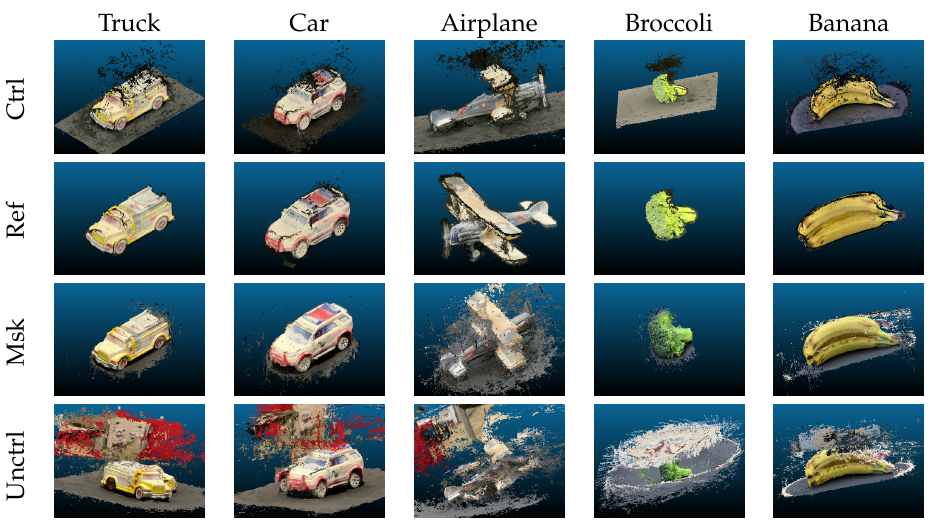
Figure 6. Example results using Agisoft controlled environment, Ref—hand cleaned version of Ctrl, Msk—uncontrolled environment masked using our pipeline, Unctrl—uncontrolled environment.